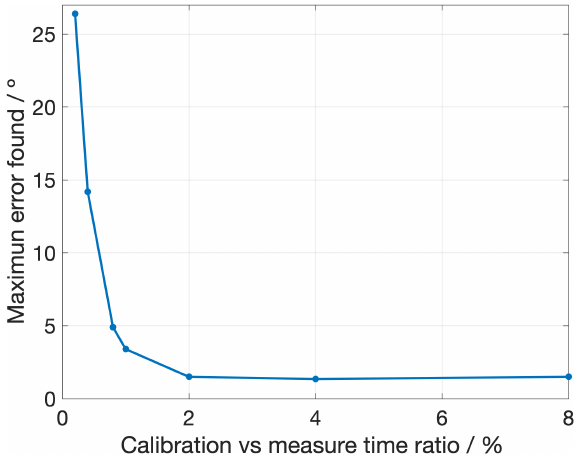
Figure 8. Maximum error found after applying our calibration method for different ratios between the time used for calibration measurements and the time used for sky ones.